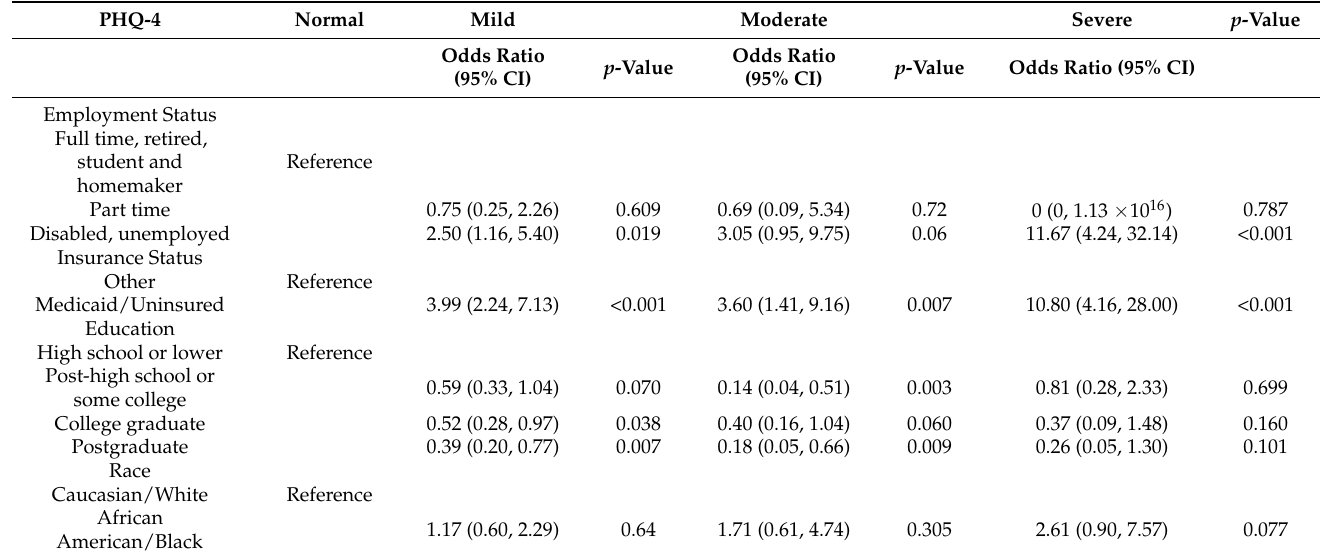
Table 2. Univariate model (CA & AA). PHQ-4 score change and 95th percentile confidence interval for correlations between socioeconomic status and PHQ-4 score.